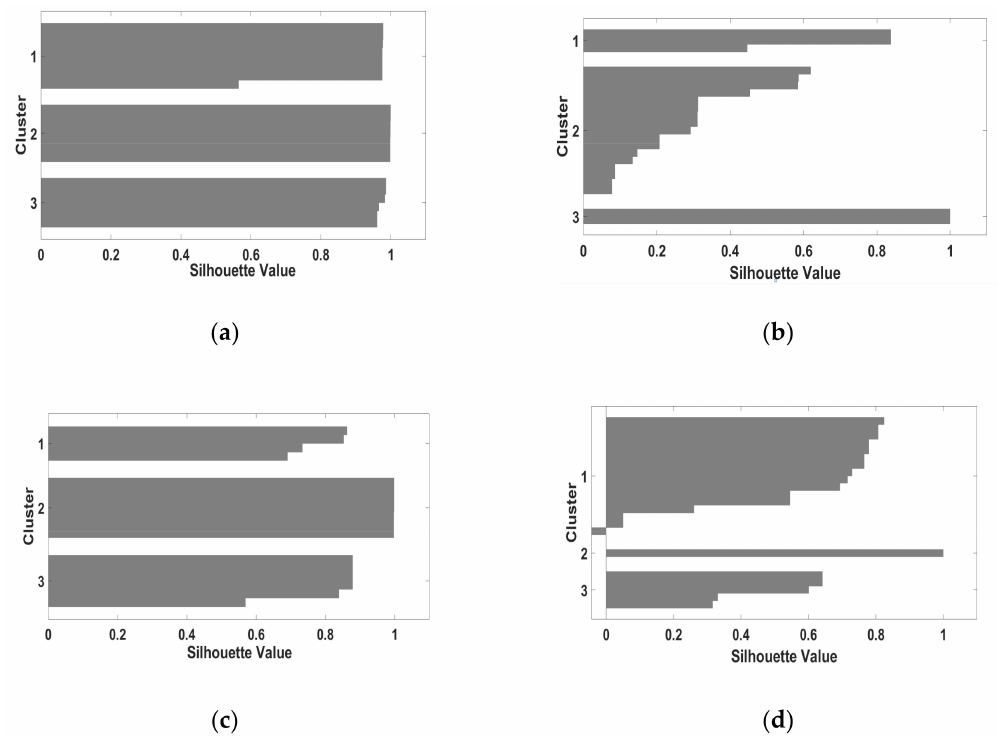
Figure 6. Cluster validity for S-Jaccard values for denoised images belonging to D2. The name of the images follows the pattern: Diagnose Index / MRI image type. ( a ) S-Jaccard_ healthy / T2w; ( b ) S-Jaccard_ glioma / T2w; ( c ) S-Jaccard_ healthy / PD; ( d ) S-Jaccard_ glioma / PD.